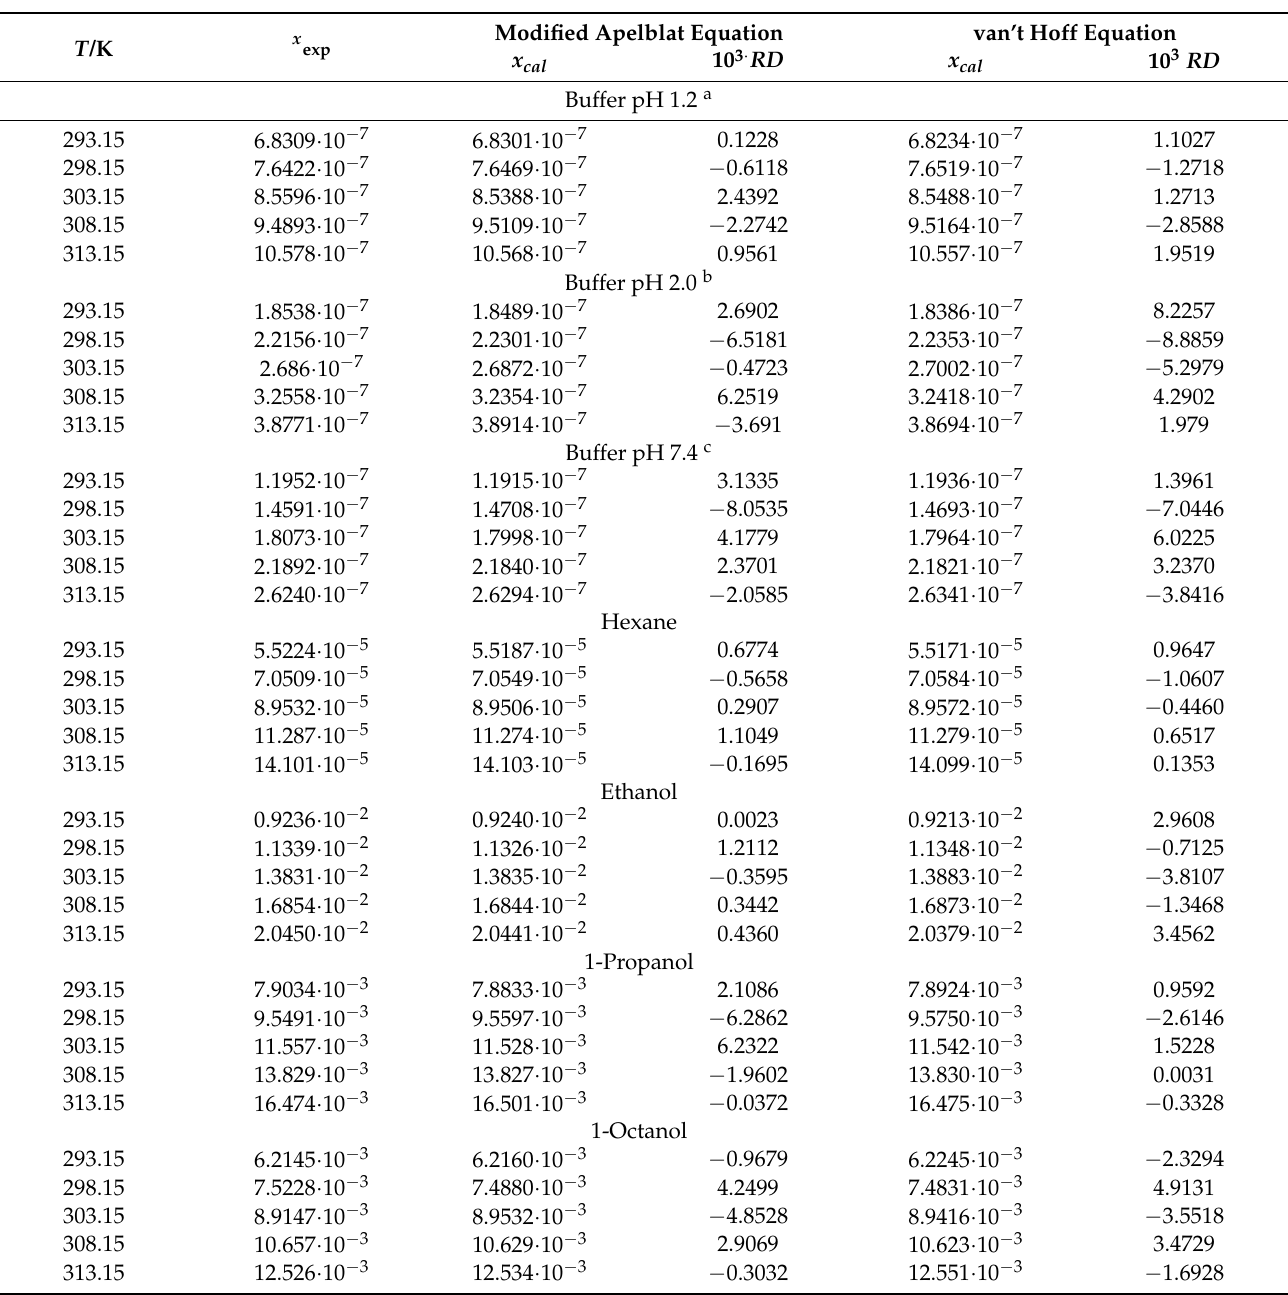
Table 4. Experimental ( x exp ) and correlated ( x cal ) mole fractions of compound studied solubility in the solvents studied at different temperatures and pressures p = 0.1